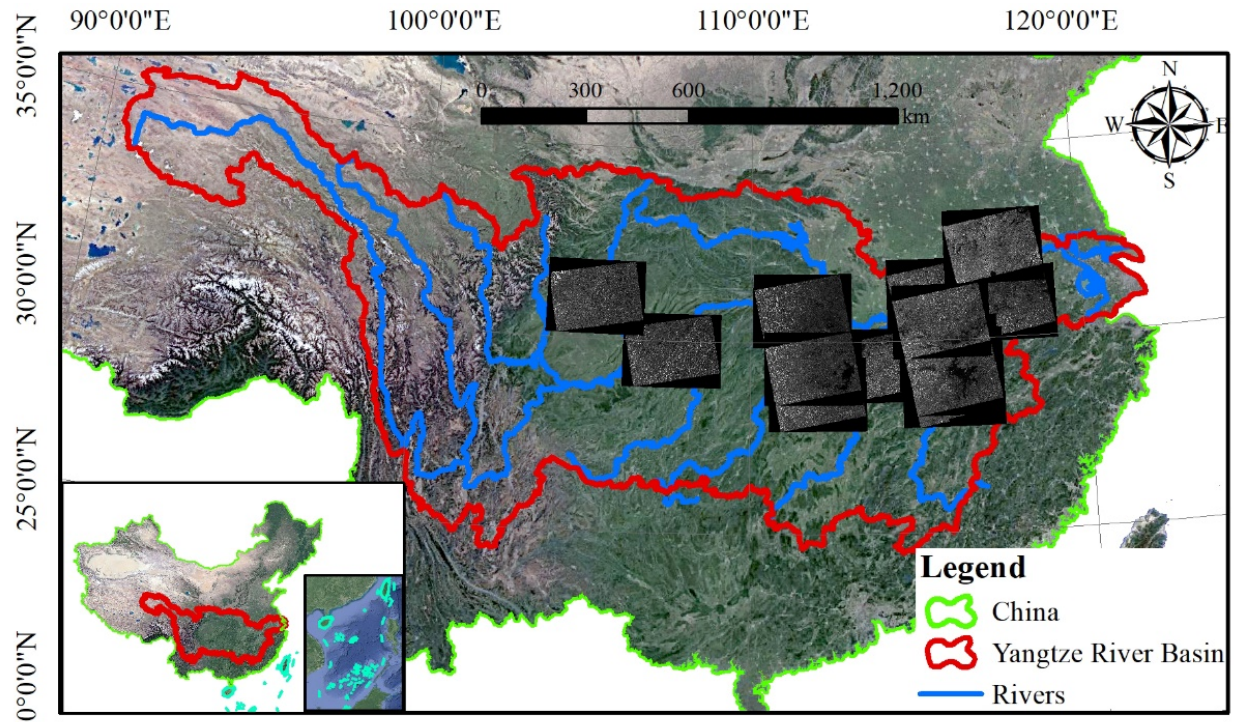
Figure 1. Geo-location of the YRB and the locations of the satellite data used in present study.